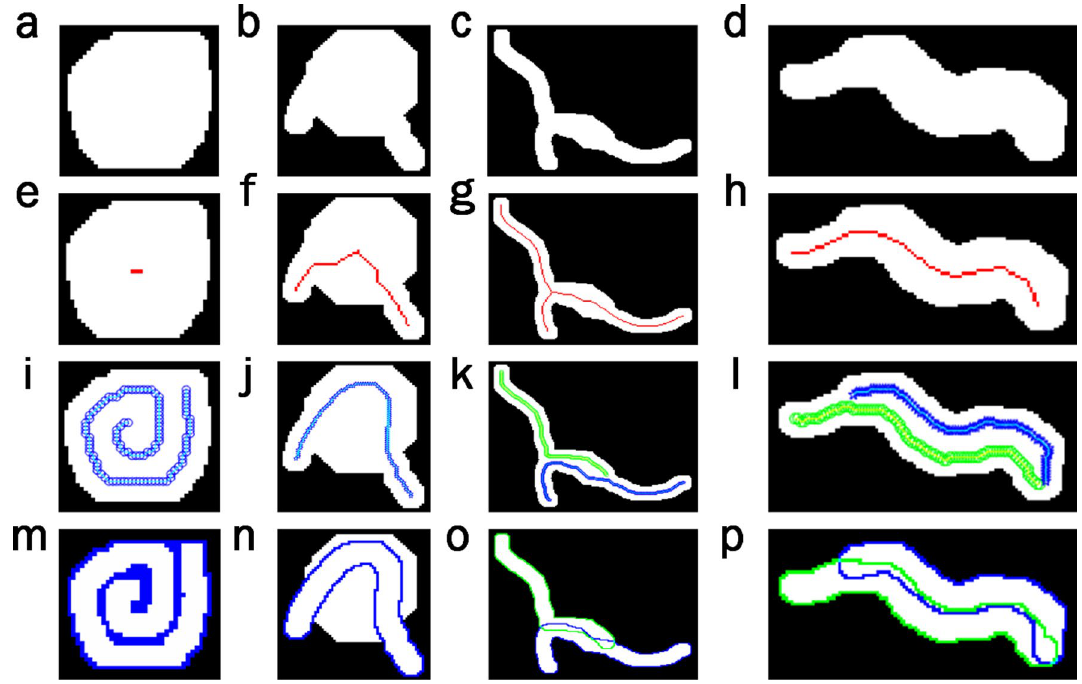
Figure 3. Comparison of skeleton methods. Each of C. elegans columns fully wound, C. elegans colliding with noise on the plate, C. elegans partially in contact, two C. elegans traveling in parallel, which correspond to different cases that present problems when tracking is done by a classic skeletisation method with possible loss of identity. ( a – d ) Worm segmentation. ( e – h ) Skeletons obtained by a classic computer vision method in red.